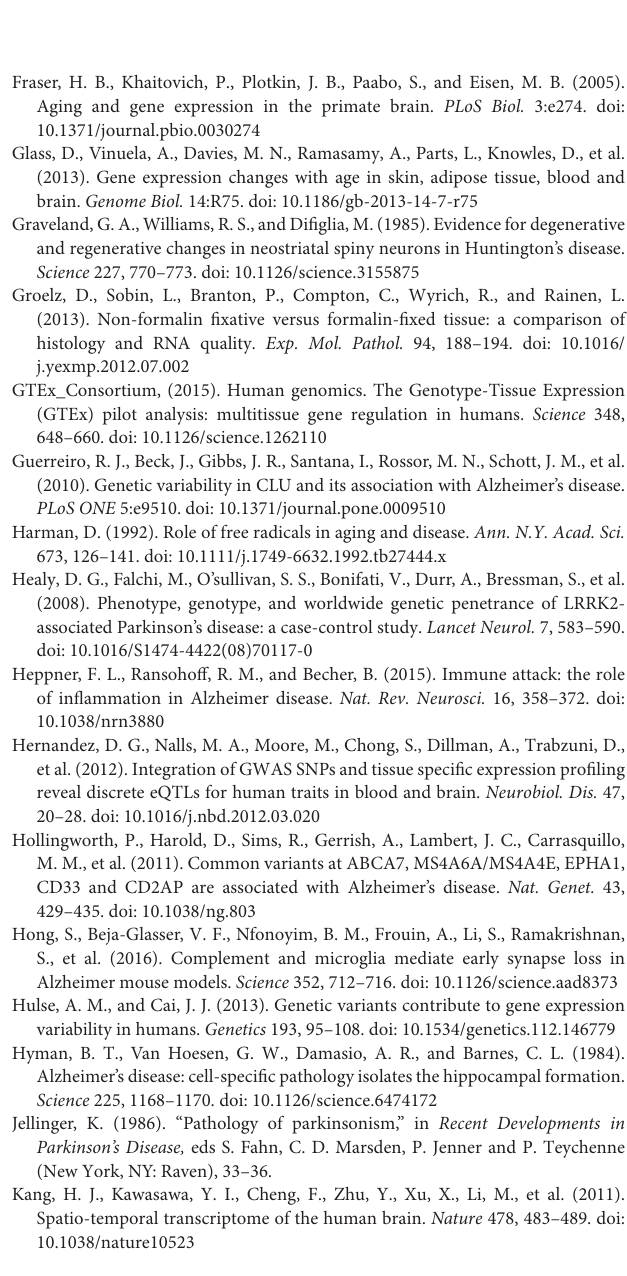
Supplementary Figure S3 | Flowchart summary of methods described in this paper. Output can be found in the figures and tables indicated on the far right-hand side of the figure. Supplementary Figure S4 | Diagram showing regions of the brain with age-related gene expression differences indicated in parentheses. Here, we show numbers of age-related genes that are up- or down-regulated at FDR 5%. Approximate locations of some regions are delineated with a dashed-line border, as not all regions are located within the same plane. Supplementary Table S1 | Age-related genes whose expression is correlated or anti-correlated with chronological age, across all regions investigated. Supplementary Table S2 | Age-related genes identified by randomly subsampling samples to 54 (the minimal sample size) for all regions.